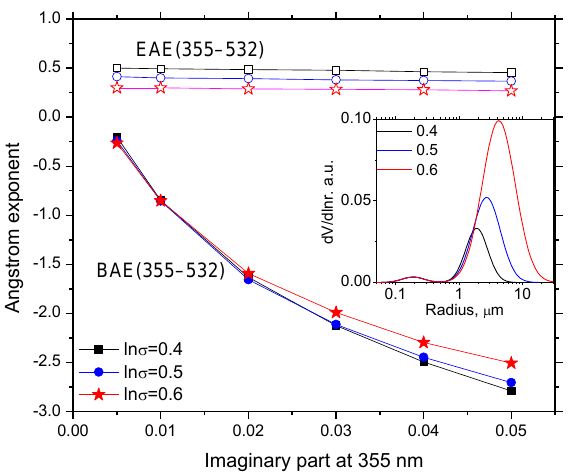
Figure 13. Extinction and backscattering Ångström exponent for 355/532nm wavelengths as a function of the imaginary part of the refractive index at 355nm. The CRI at 532nm was kept m = 1 . 55 − i. 005. Computations were performed using the model of ran- domly oriented spheroids. The insert shows three bimodal PSDs with ln σ = 0 . 4, 0.5, 0.6 used in computations.